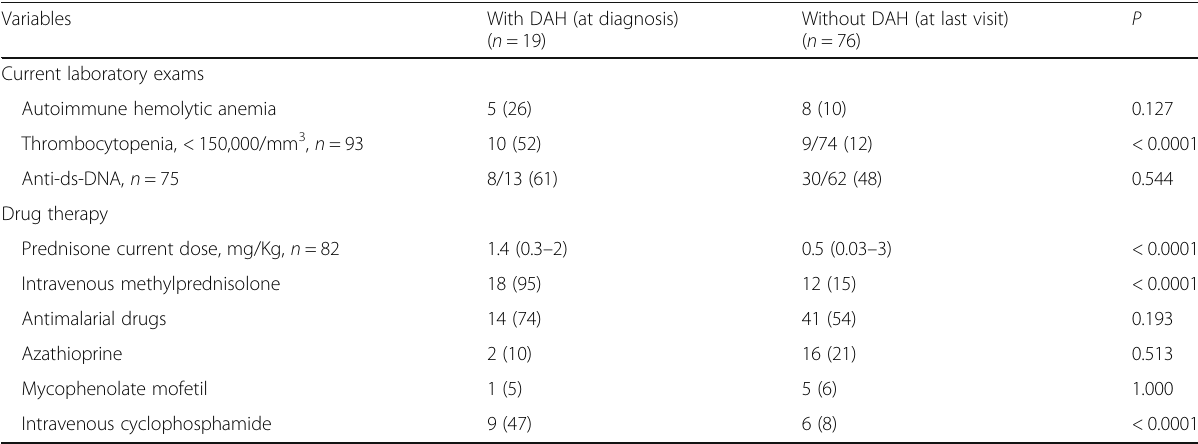
Table 4 Current laboratory tests and drug therapy of childhood-onset systemic lupus erythematosus (cSLE) according to the presence of diffuse alveolar hemorrhage (DAH) Variables With DAH (at diagnosis)